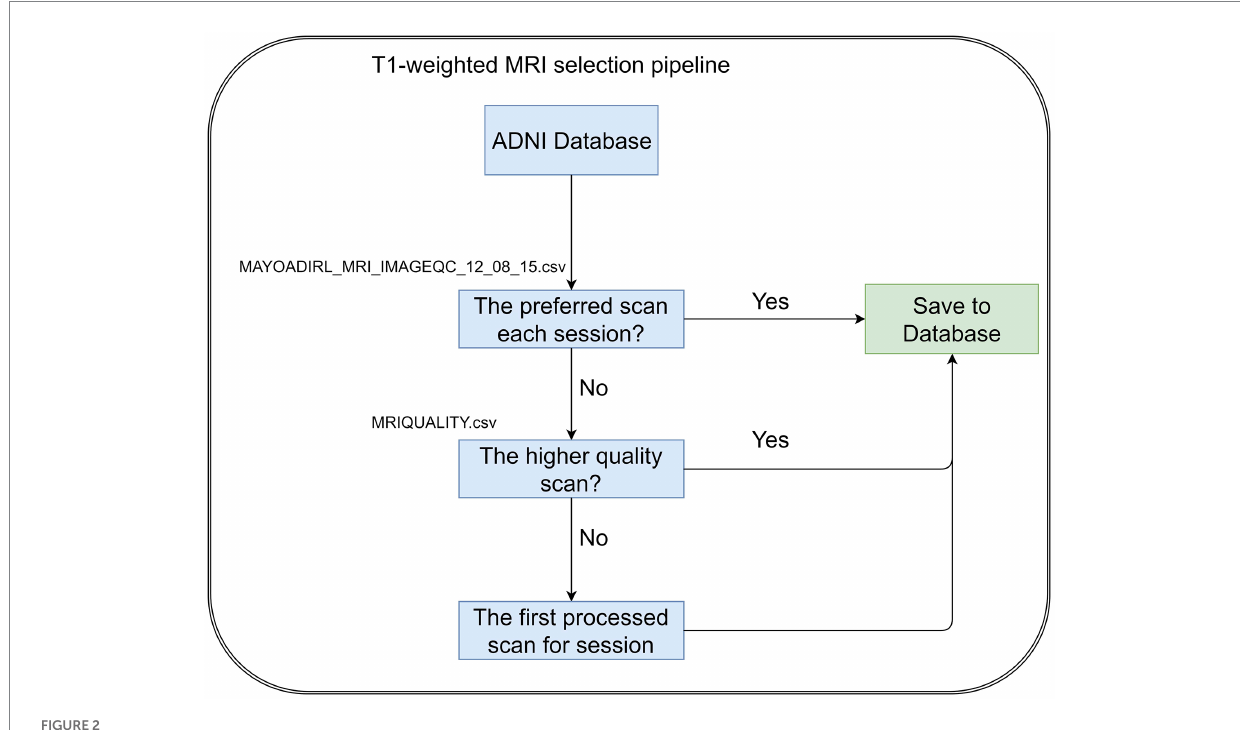
FIGURE 2 T1-weighted MRI scans